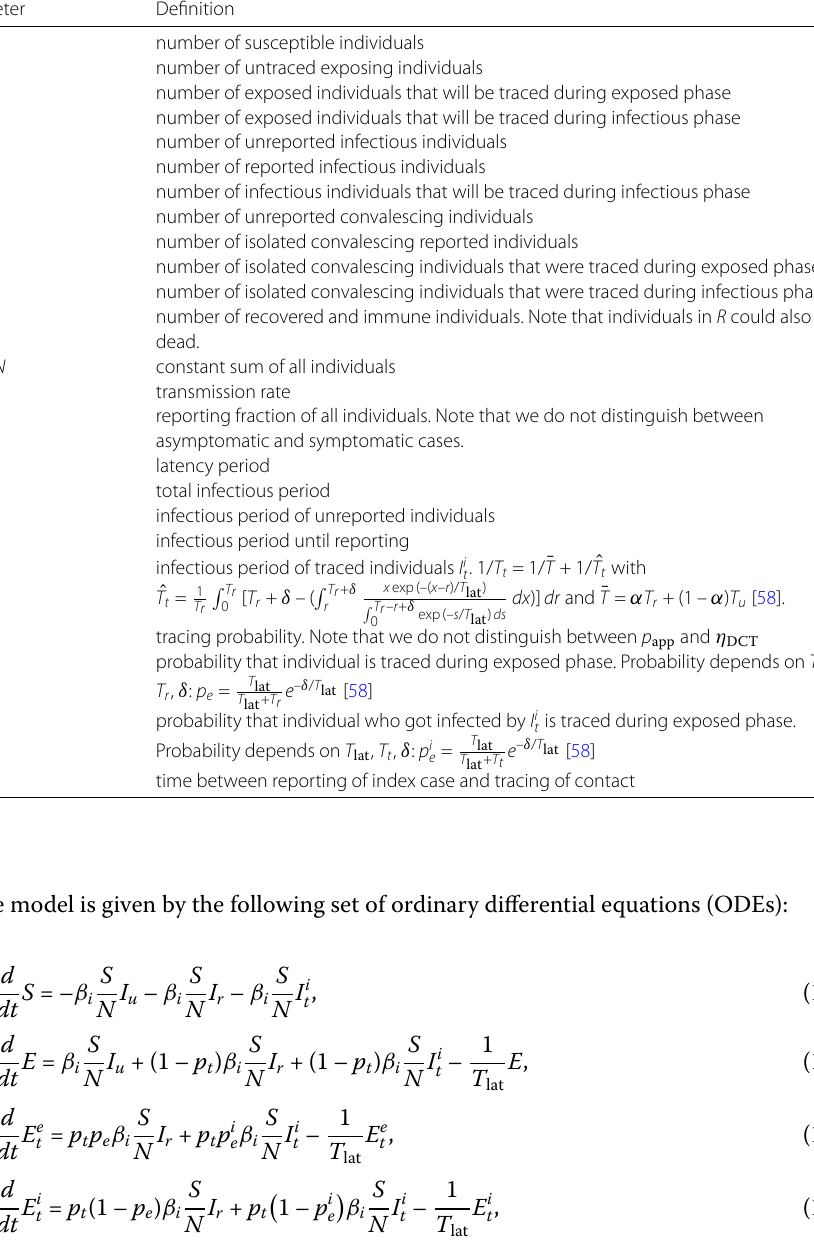
Table 3 Parameters and Definitions of the compartmental model